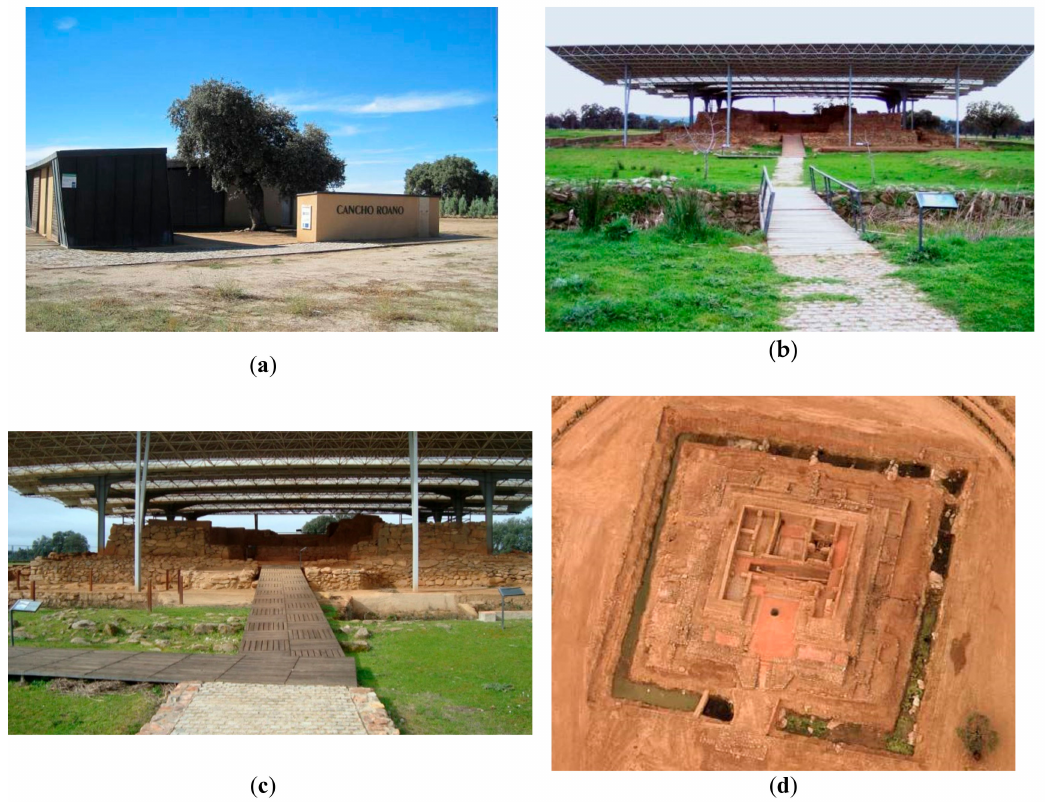
Figure 1. Cancho Roano site: ( a ) interpretation center and beginning of the brick road; ( b ) access to the ancient building; ( c ) wooden access ramp; ( d ) aerial view.